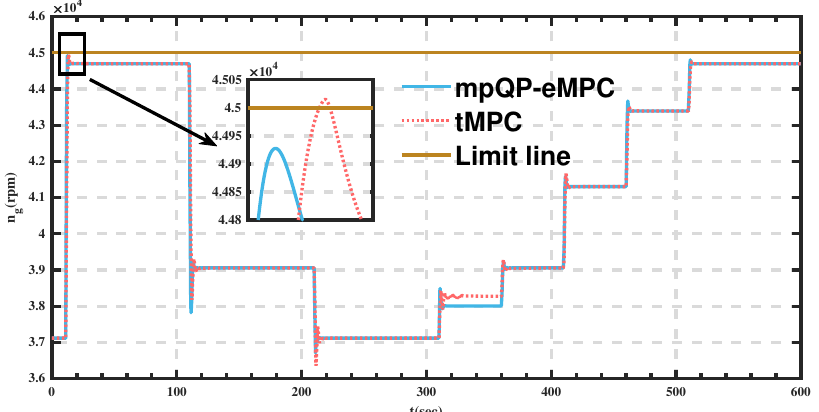
Figure 16. Speed response curves of power turbine.